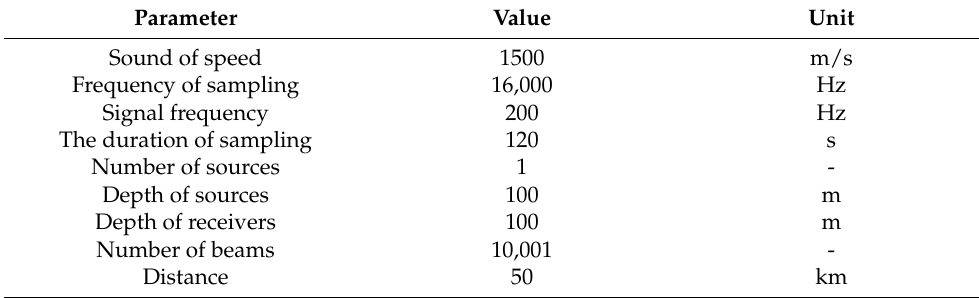
Table 1. Input parameters of the simulation.